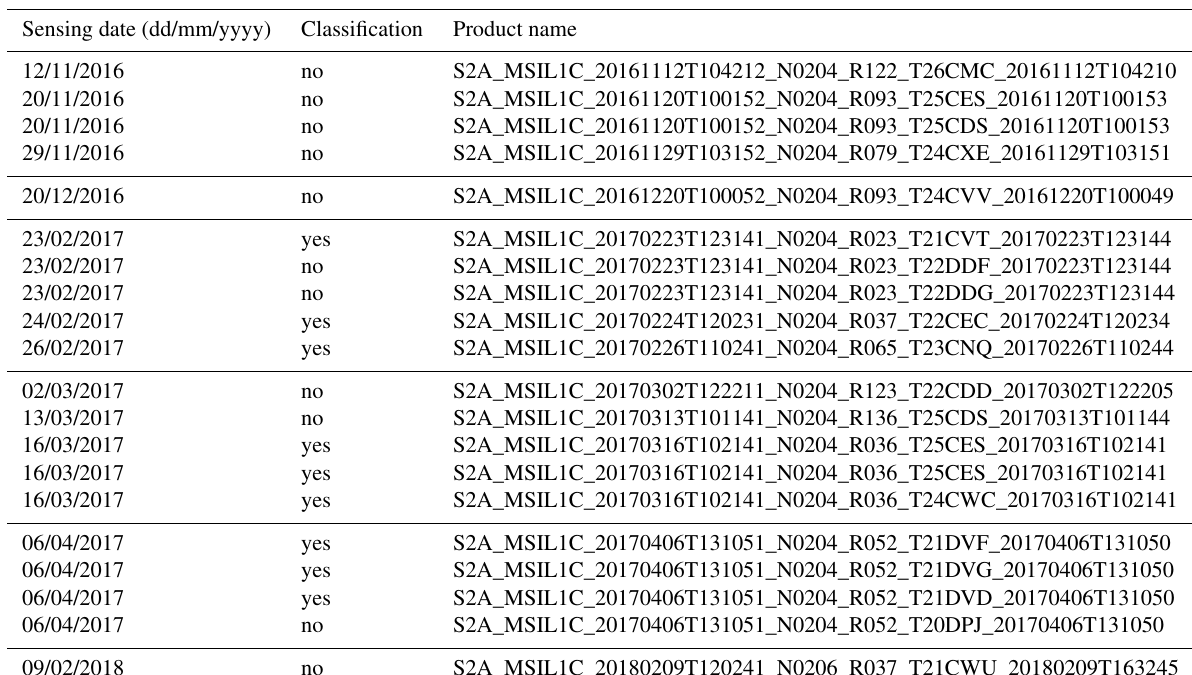
Figure 1. Display of the selection steps for the 20 Sentinel-2 Level-1C products. The location of the 20 different Sentinel-2 Level-1C products for this study is the Weddell Sea. Of the 20 products, 9 were used for the sea-ice surface-type classification (red border), while for the lead-width detection all 20 were used (red and blue border). For the border of the product the “real image outlines” are displayed, which are not always rectangular since the satellite swath does not always overlap completely with the processing grid applied by ESA. Displayed in gray is the Antarctic continent border including the shelf ice border measured with different satellite radar from 2007–2009 (Mouginot et al., 2017; Rignot et al., 2013). Table 1. Sentinel-2 Level-1C products used for measuring the lead width. Products which are also used for the classification are labeled with